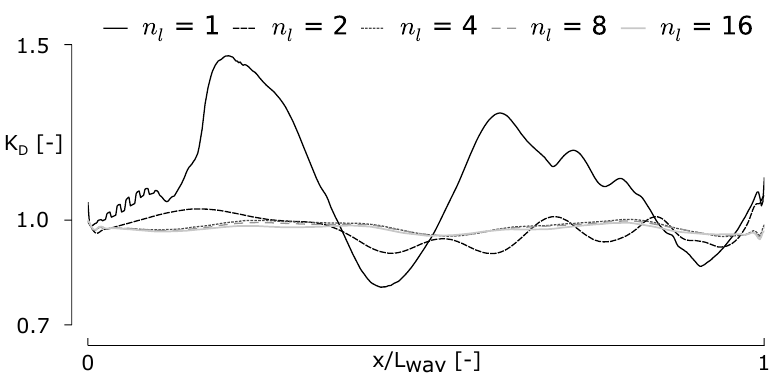
Figure 3. Sensitivity analysis on the number of buffer particle layers n l necessary for accurate wave propagation, represented by the ratio K D along the fluid domain.